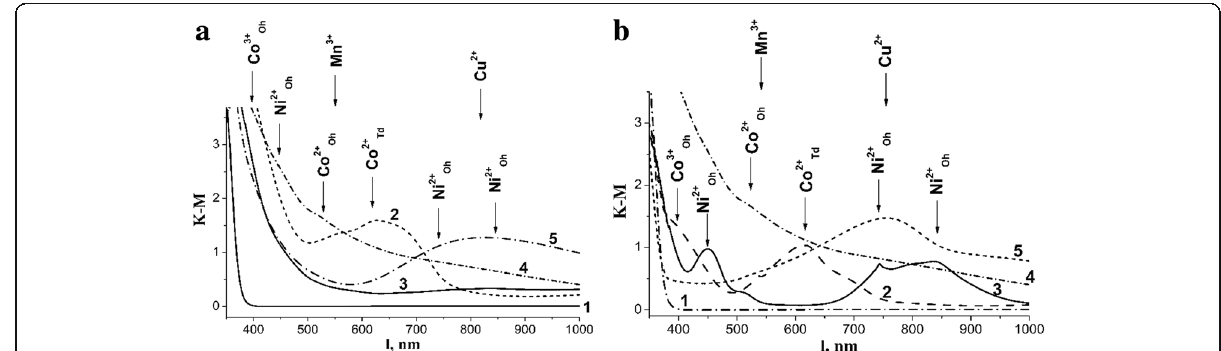
Fig. 3 Diffuse reflectance spectra of the powders prepared from the films precursors: TiO 2 ( 1 ) and TiO 2 doped with 5% Co ( 2 ), Ni ( 3 ), Mn ( 4 ), and Cu ( 5 ) calcined at 450 ( a ) and 650 °C ( b